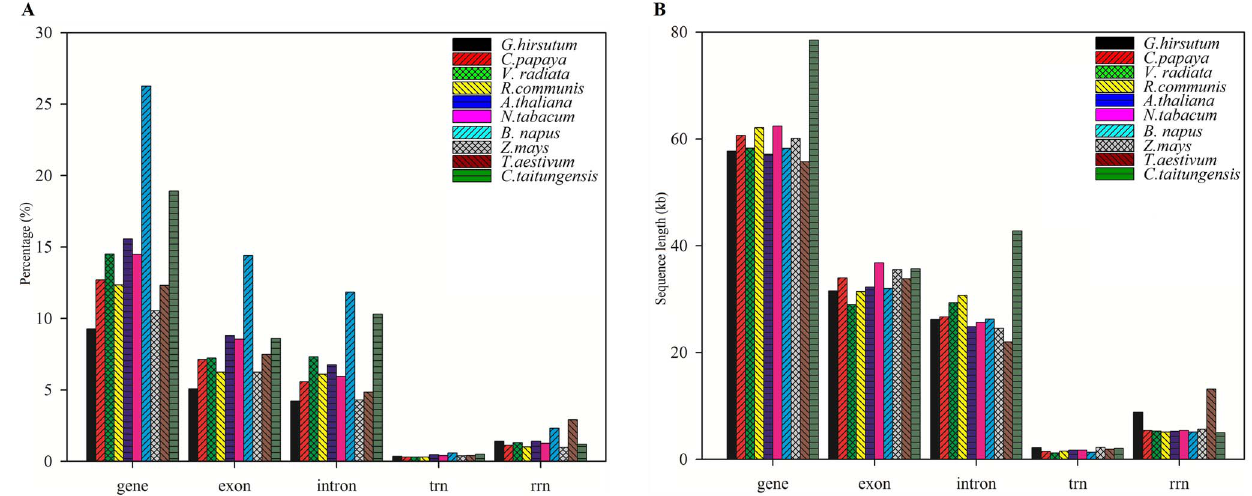
Figure 2. Gene composition of different mitochondrial genomes. The percentage of different genic sequence (A) and the length of different genic sequence (B).